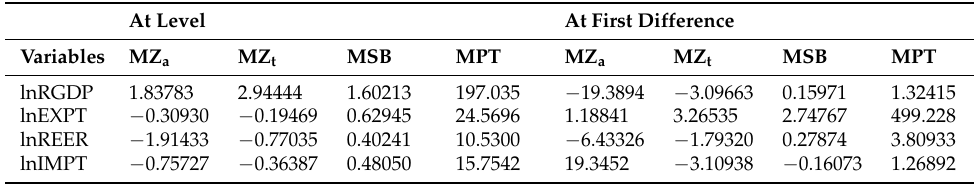
Table 1. Ng Perron Unit root at Level.